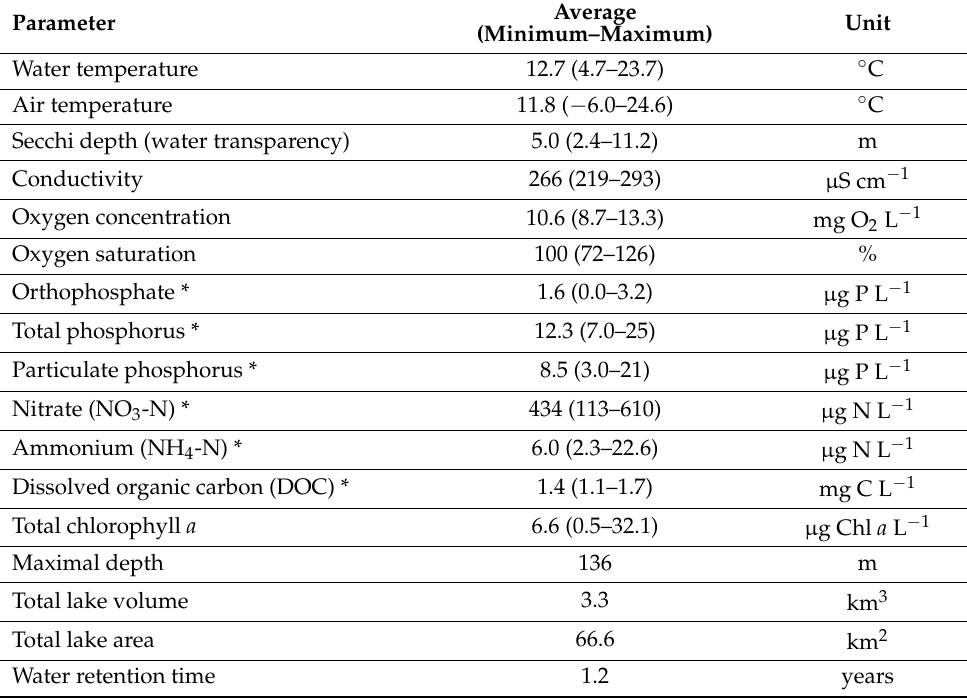
Table 1. Major limnological characteristics of Lake